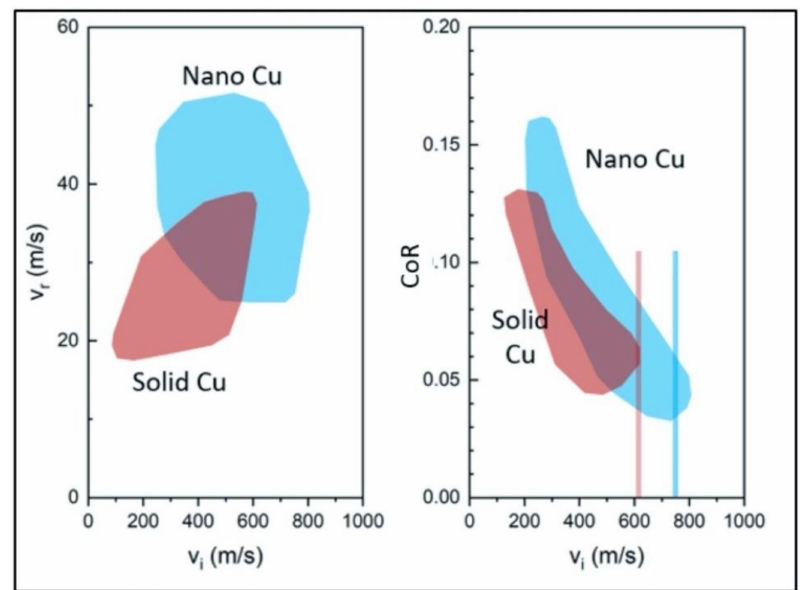
Figure 11. Reformulation of the V r vs. V i and CoR vs. V i for GA Cu (labeled as Solid Cu) and spray-dried Cu (labeled as Nano Cu)